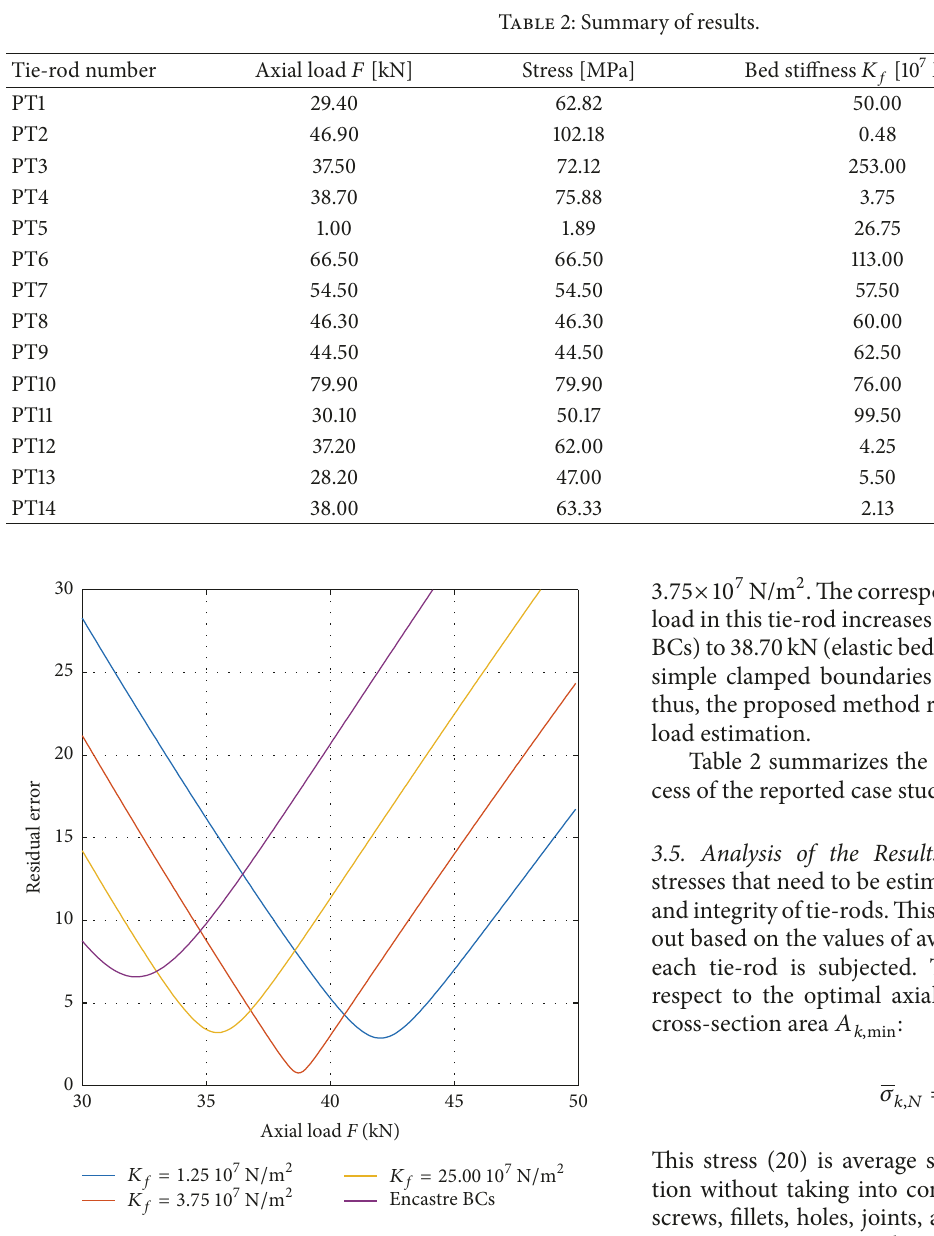
Figure 7: Influence of the elastic bed on the axial load determina-